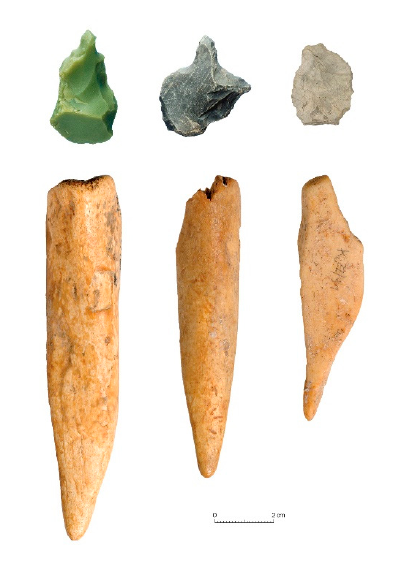
Figure 4. Tools suitable for perforating cortical bone: Pointed stone tools (the first on the right has a broken tip) and bone punches from the Mousterian layers of Divje babe I (photo Tomaž Lauko, NMS). At first glance, such artificially made holes on the diaphysis resemble holes made with teeth. The latter are almost always in the vicinity of the epiphyses and only exceptionally on juvenile diaphyses of the approximately same size, such as specimen no. 652 [16]. This is conditioned with the ability of large carnivores, i.e., physical restriction regarding the grip and muscle strength, and with the thinner cortical bone near epiphyses. Unlike animals, man was able to pierce holes along the entire femur diaphysis, regardless of the thickness of the cortical bone. While puncturing bones, people could choose among significantly more methods than animals, which instinctively always do exactly the same. Therefore, in the case of the artefact, it is easier to substantiate the problematic damage, including the above-mentioned depression near hole no. 3 on the posterior side of the diaphysis. Namely, in its vicinity, there are two parallel micro-scores on the abraded surface of the cortical bone (Figure 5), which could be interpreted as cut marks made by stone tools. These micro- scores are never mentioned by advocates of the carnivore origin of the holes. The possibility that people used the distal end a femur, which was previously damaged by carnivores, is not ruled out. Regarding the absence of other microscopic traces related to manufacture, they could have been erased due to extremely strong corrosion in the layer comprising the find. Only the more distinct scores were preserved, as well as the dent(s) (pitting after F. d’Errico [18]) made by teeth, which, considering their position, cannot be connected with certainty to the production of holes by compression and piercing with teeth. Due to their orientation and shape, all scores and dents, recognized by d’Errico and colleagues, cannot be attributed to carnivores. Carnivores make scores with their teeth that are perpendicular or slightly oblique to the axis of the diaphysis. They are not able to make a score subparallel to the axis of the diaphysis with their bites [10] (Figure 9 from Reference [10]). Some of the dents must have been made by corrosion, which was not considered by d’Errico and colleagues [39]. At least one longitudinal score could be a tool mark.